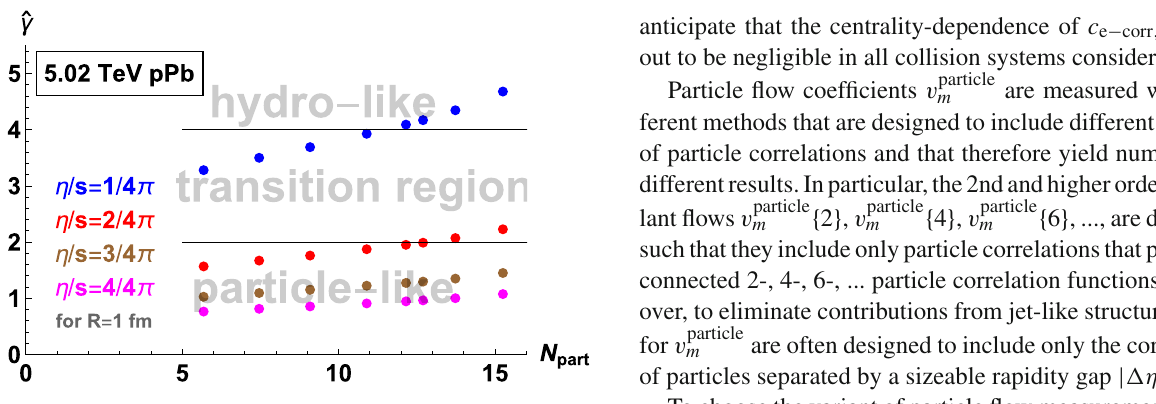
Fig. 8 The N part -dependenct of ˆ γ in pPb collisions, determined from (32) for different values of η/